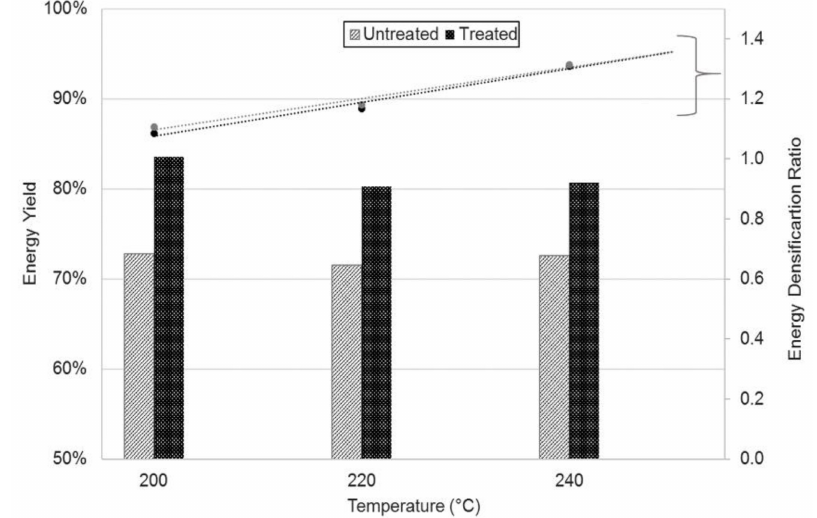
Figure 4. Energy yield and energy densification ratio of hydrothermal carbonization experiments as a function of reaction temperature for untreated and treated wood. Energy yield as bars is shown on left axis, while points and trendline show energy densification on right